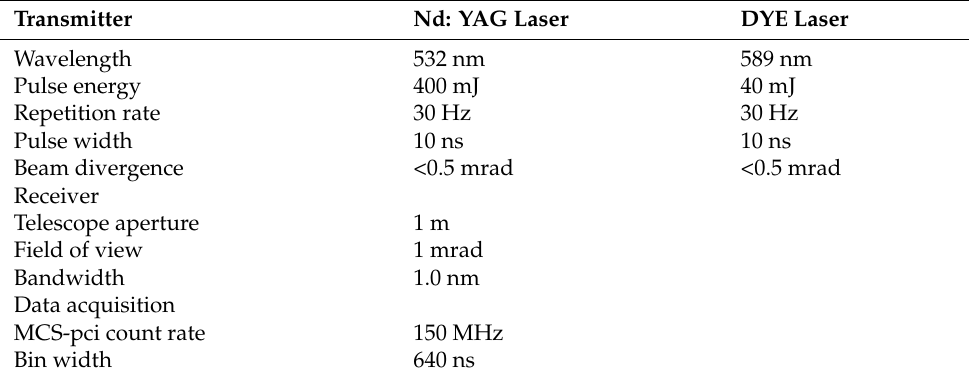
Table 1. System parameters of the multiple channel lidar